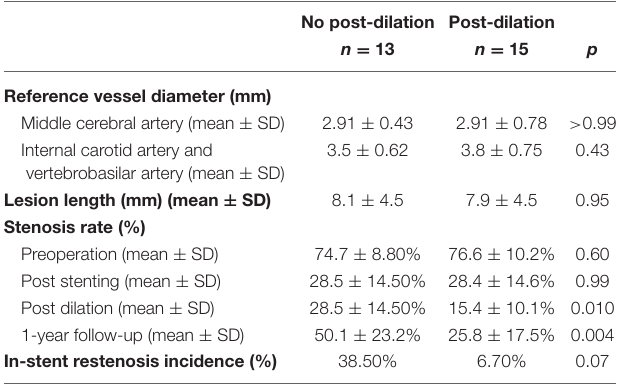
TABLE 2 | The lesion characteristics and the stenosis rate